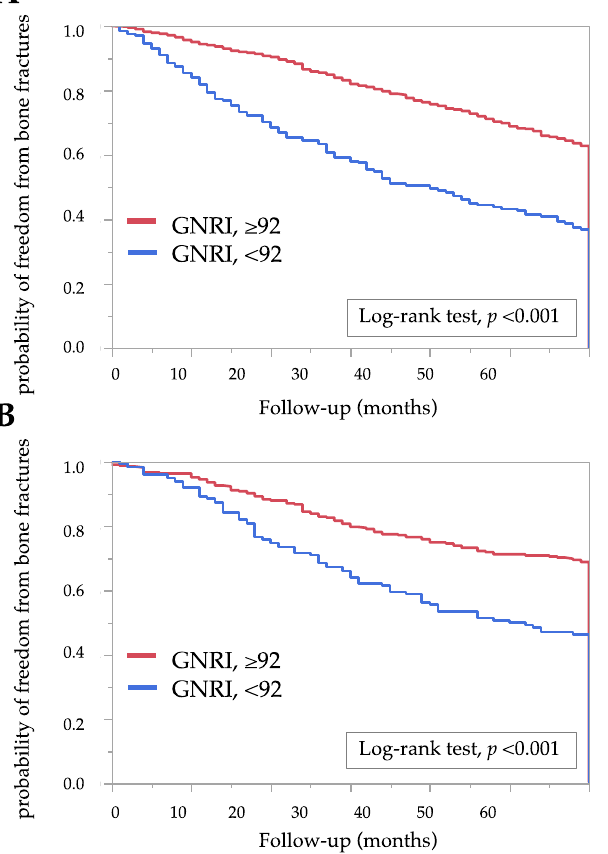
Figure 2. Kaplan–Meier estimates of the probability of freedom from bone fractures according to two GNRI groups: ( A ) male and ( B ) female. The log-rank test was used in analysis. A two-tailed p < 0.05 was considered statistically significant. Abbreviations: GNRI , geriatric nutritional risk index. Table 3. Hazard ratios for bone fractures in ( A ) males and ( B ) females.